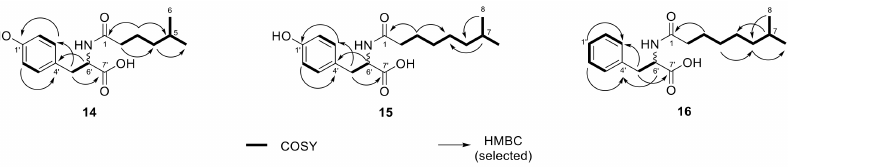
Figure 6. Chemical structures of N -acyl amino acids ( 14 – 16 ) isolated from Olivibacter sp. FHG000416, with observed COSY (in bold) and key H → C HMBC (arrows)